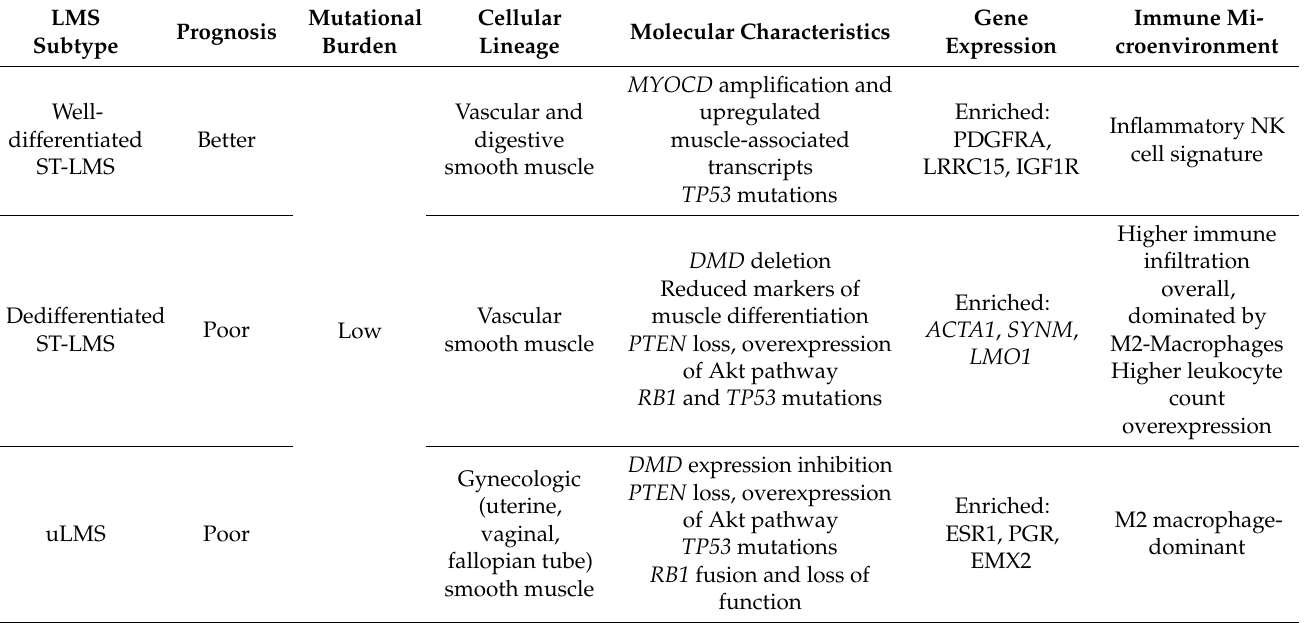
Table 2. Characterization of LMS as defined by three major molecular